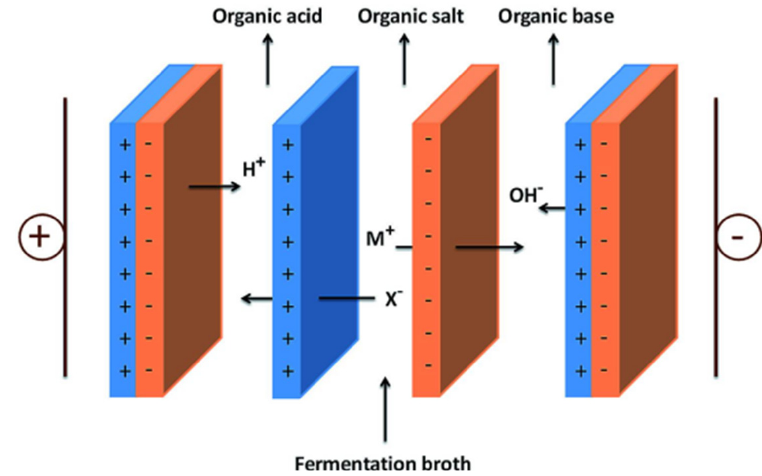
Figure 7. Schematic of the EDBM stack configuration for producing organic acids [72].